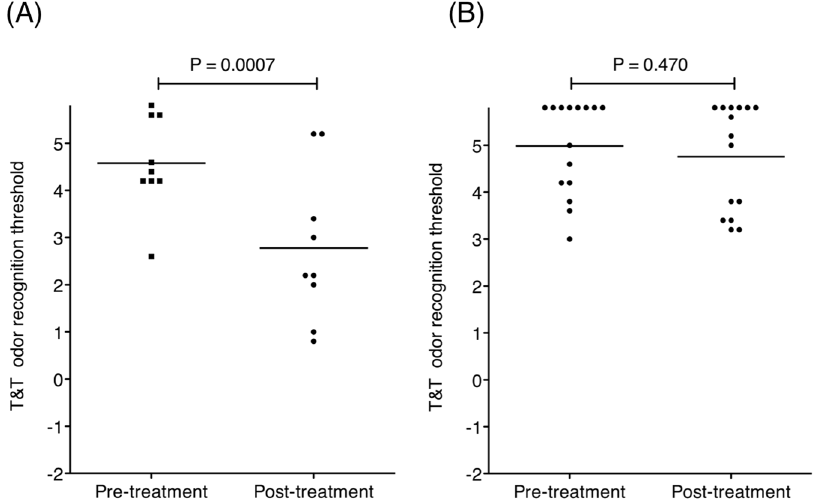
Figure 1. Differences in the odor recognition thresholds determined by T&T olfactometry (T&T odor recognition threshold) following conventional treatment with the Japanese herbal medicine tokishakuyakusan. Smaller numbers of odor recognition thresholds indicate higher sensitivities to odors. ( A ) Patients with high nasal 201 Tl migration to the olfactory bulb (N = 9). ( B ) Patients with low nasal 201 Tl migration to the olfactory bulb (N = 15). Bars indicate